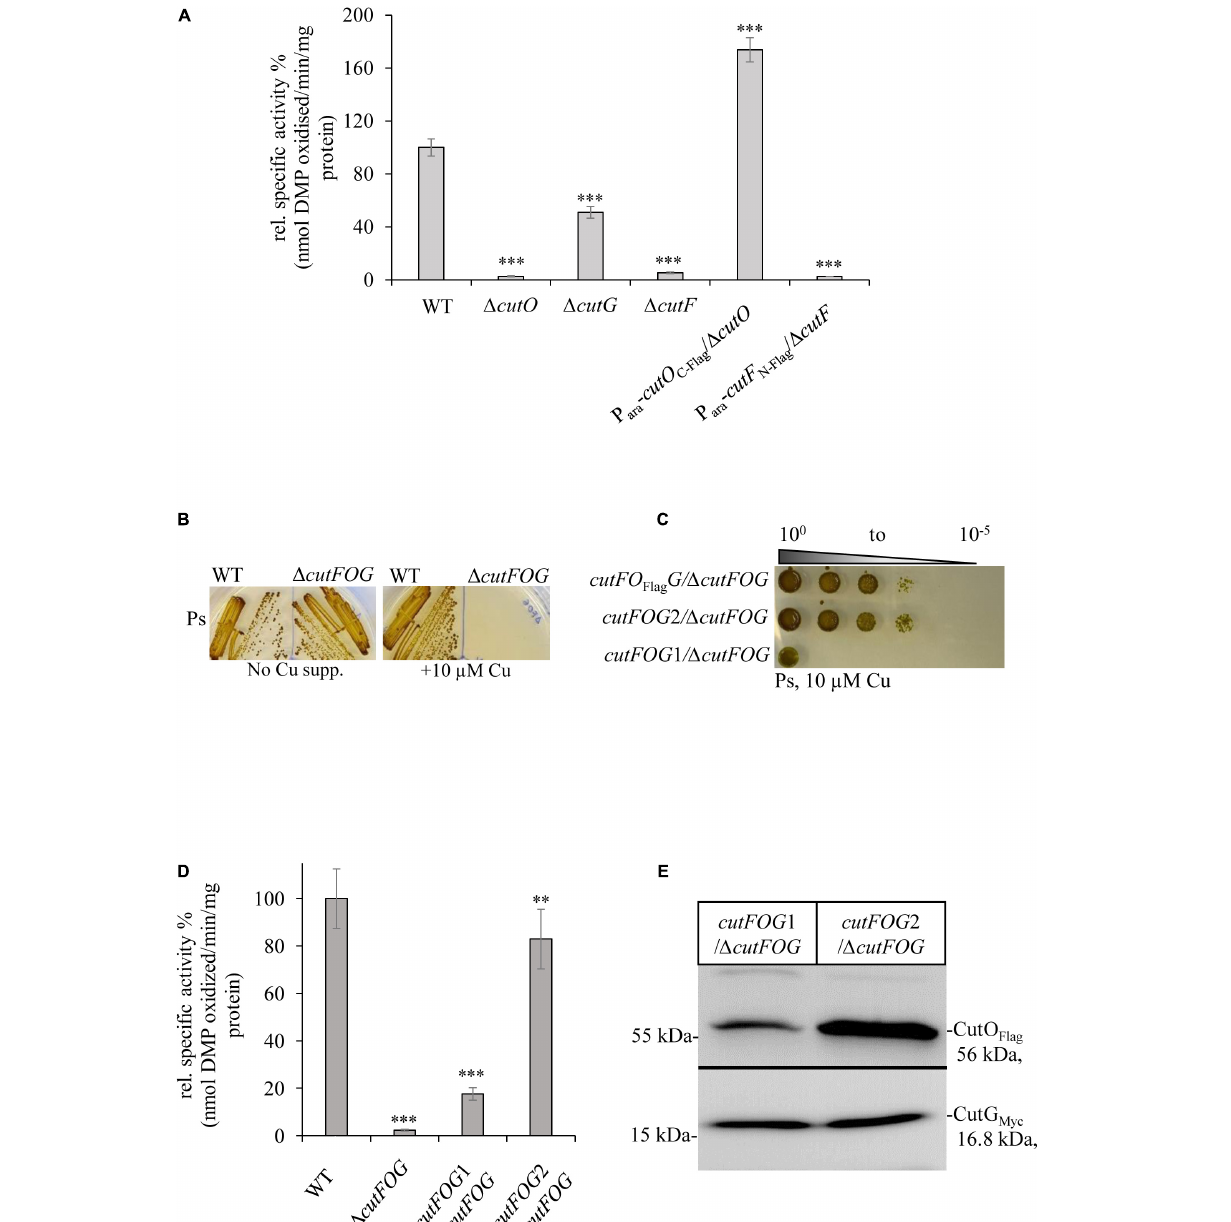
Frontiers in Microbiology |